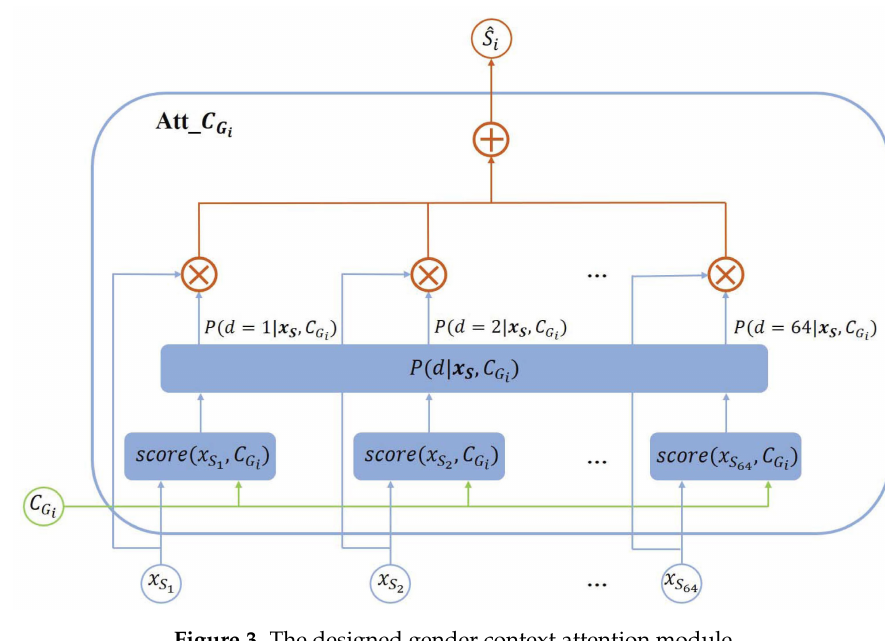
Figure 3. The designed gender context attention module.